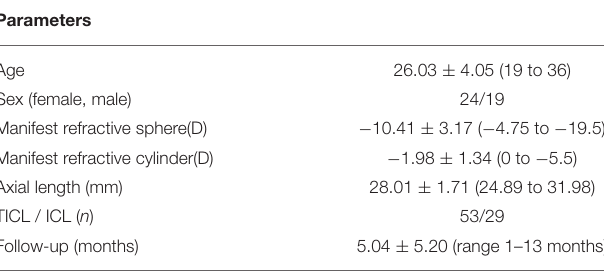
TABLE 1 | Baseline patient characteristics.